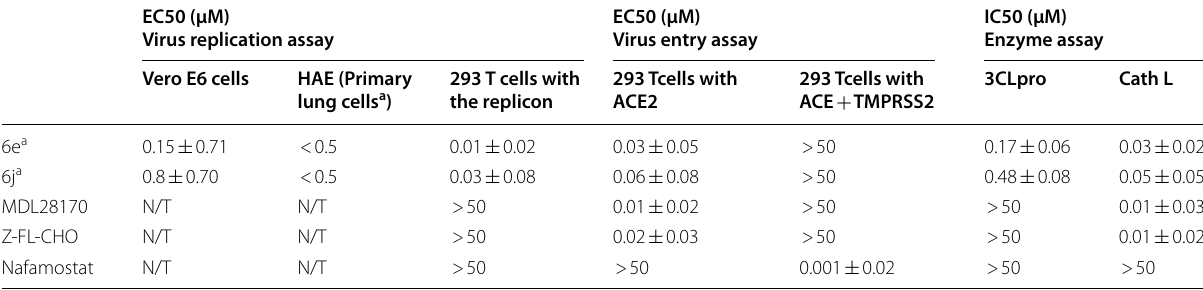
a 6e and 6j were reported in ref (Rathnayake et al.